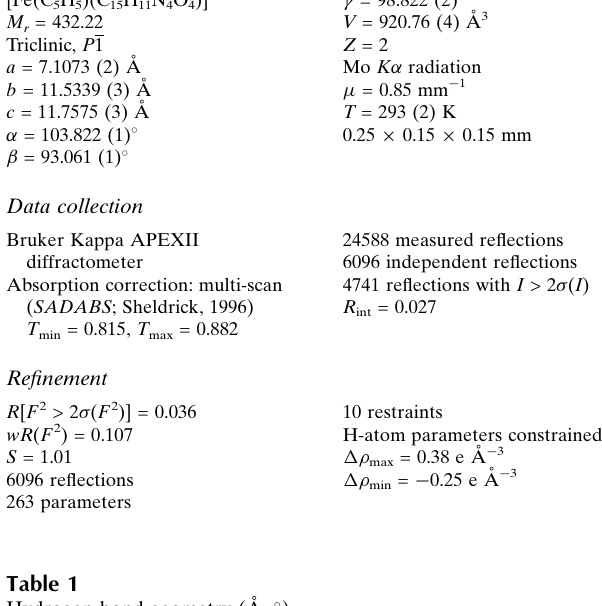
Hydrogen-bond geometry (A˚ , (cid:1)